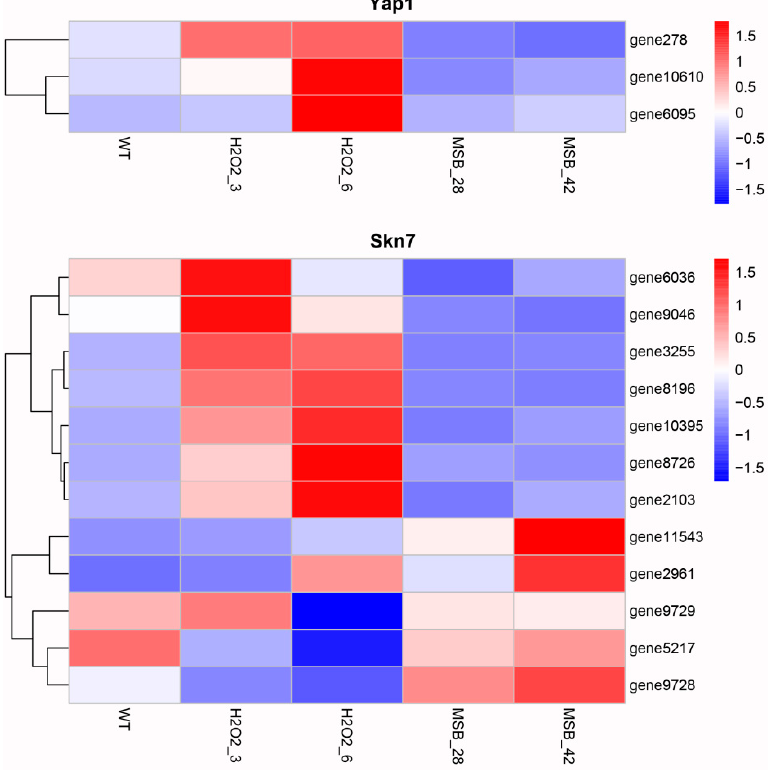
Figure 4. The expression profile of Yap1 and Skn7 transcription factors in the five samples. WT: the control; H 2 O 2 : the H 2 O 2 treatments (3 and 6 mM); MSB: the MSB treatments (0.28 and 0.42 mM).